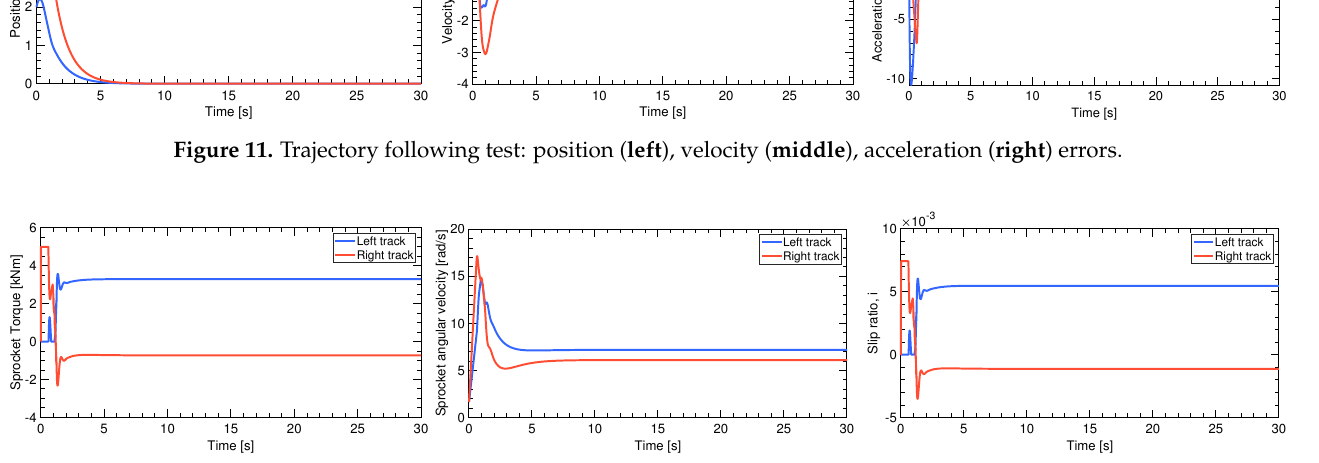
Figure 12. Trajectory following test: torque behavior ( left ), sprocket rotational velocity ( middle ), slip of the track ( right